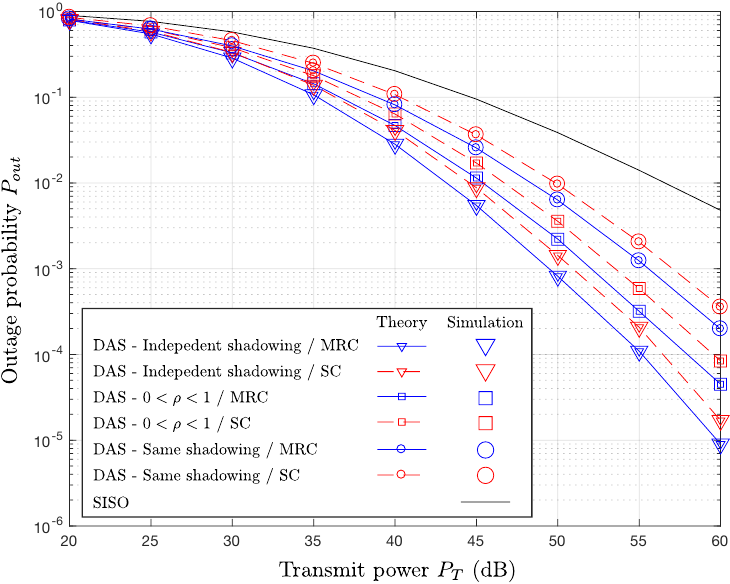
Figure 3. Outage probability P out versus transmit power P T , when γ th = 10 − 3 , l = 30 m, ∆ t = 15 m, n = 4, and σ = 8